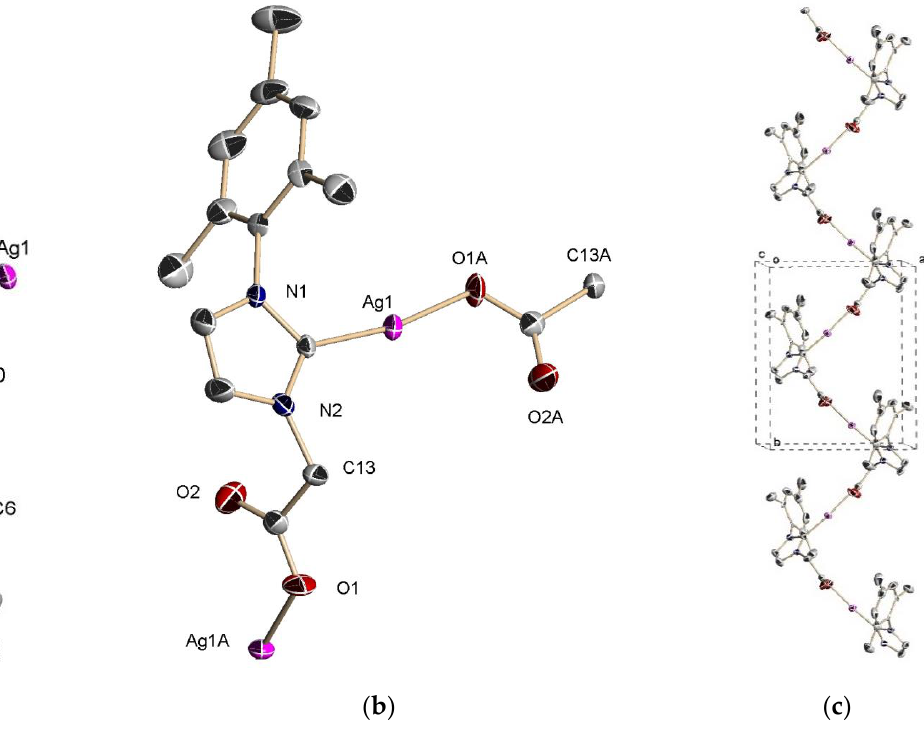
Figure 1. ( a ) Asymmetric unit of complex 2a . ( b ) Coordination around silver atom in 2a . ( c ) Coordination 1D polymer formed by 2a viewed along c axis.